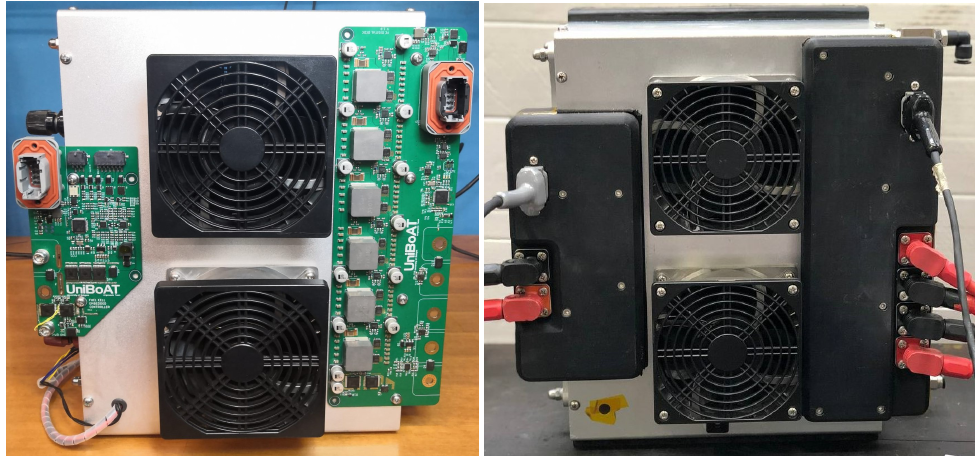
Figure 18. Photo of the complete system prototype comprising the H-2000 fuel cell, the controller ( left -side board) and the DC-DC converter ( right -side board) with and without